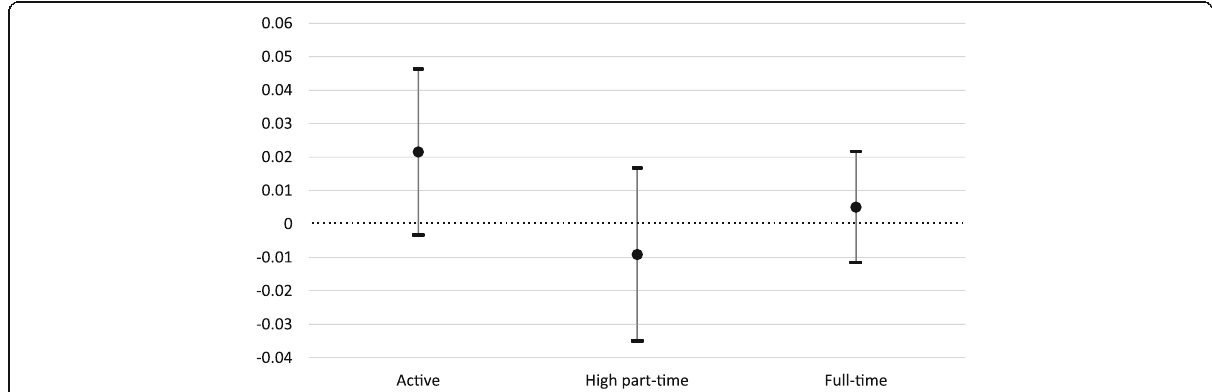
Fig. 3 Estimates for the parallel trend assumption test. Source: Swiss Labour Force Survey 1992 – 2014. Coefficients are represented with their 95% confidence intervals. Insignificant coefficients validate the parallel trend assumption